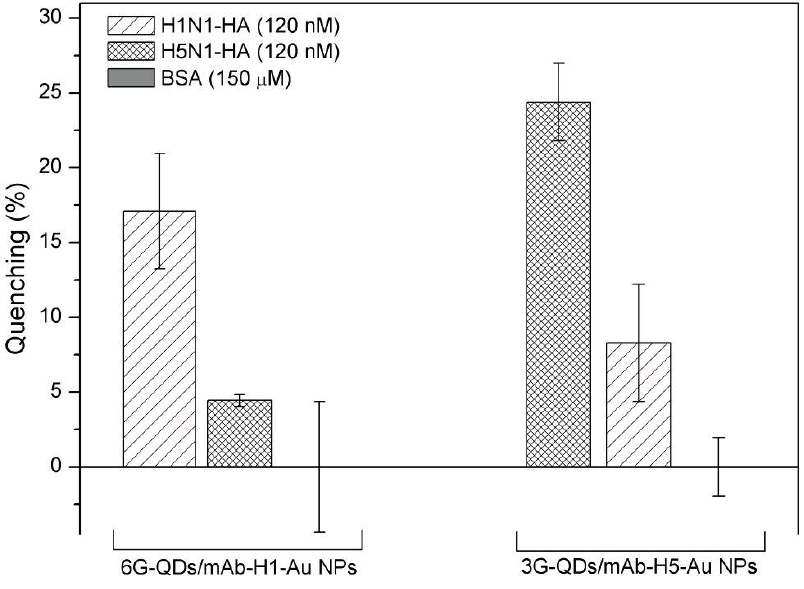
Figure 4. Cross-reactivity of two assays with human influenza virus H1N1 HA and avian influenza virus H5N1-HA. The mixtures, prepared with 6G-QDs/mAb-H1-Au NPs and with 3GQDs/mAb-H5-Au NPs, were tested using HAs derived from A/New Caledonia/20/1999 and A/Viet Nam/1194/2004 (120 nM), respectively. The control experiment was carried out using BSA (150 μ M), (N =